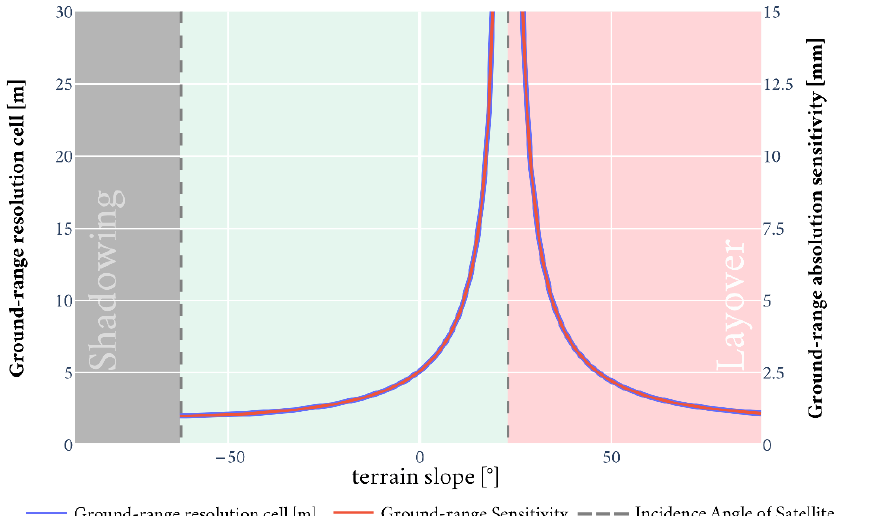
Figure 5. The relationship between incidence angle, slope and ground range resolution/sensitivity. Assuming slant range resolution is 2 m and slant range sensitivity is 1 mm [3,4]. Courtesy of